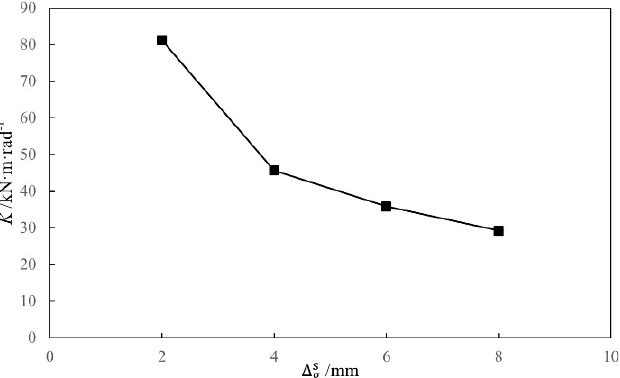
Figure 21. Moment-rotation curves of SMTJ/WP at different widths of the gap.